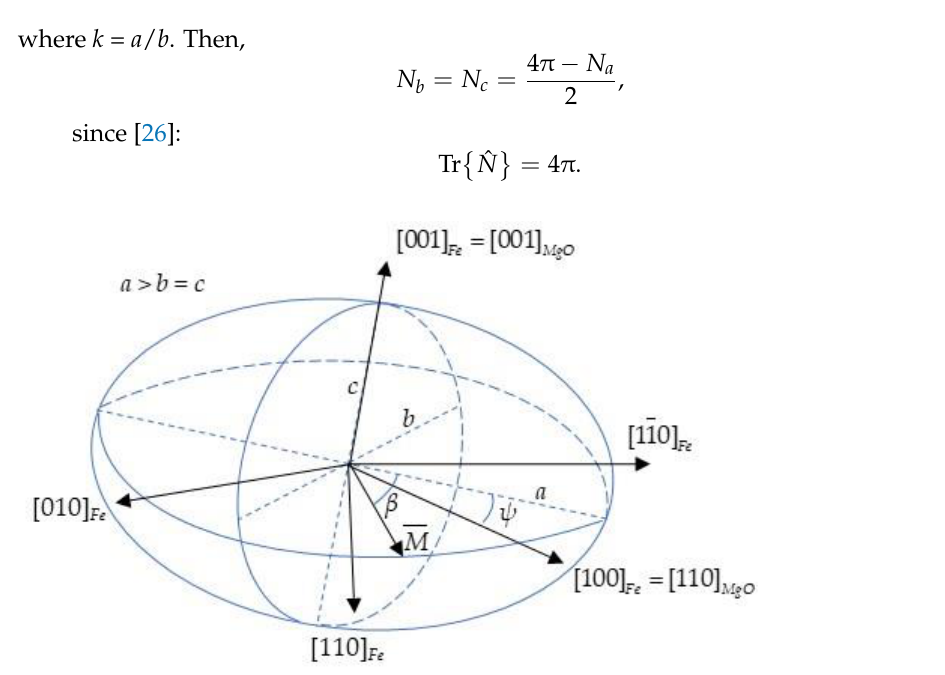
Figure 7. Frame used for the analysis of the shape anisotropy.